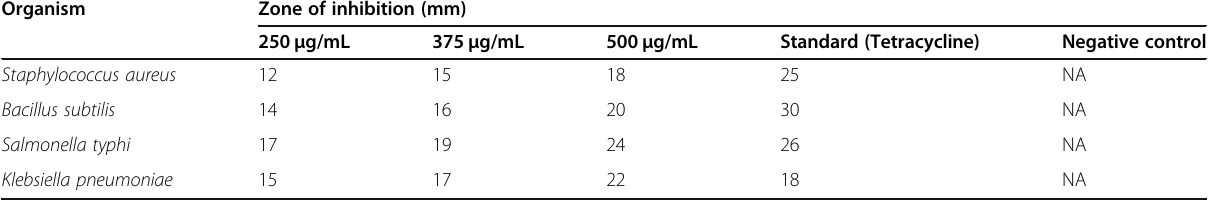
Table 3 Antibacterial activity of root extract of S. heyneanus against selected bacterial strains. NA, no activity Organism